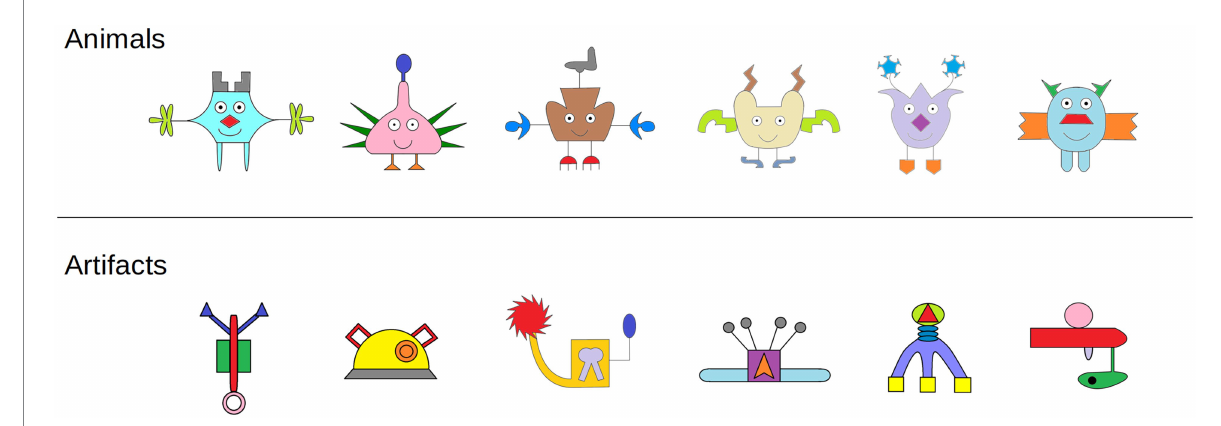
FIGURE 1 All stimuli from Experiments 1 and